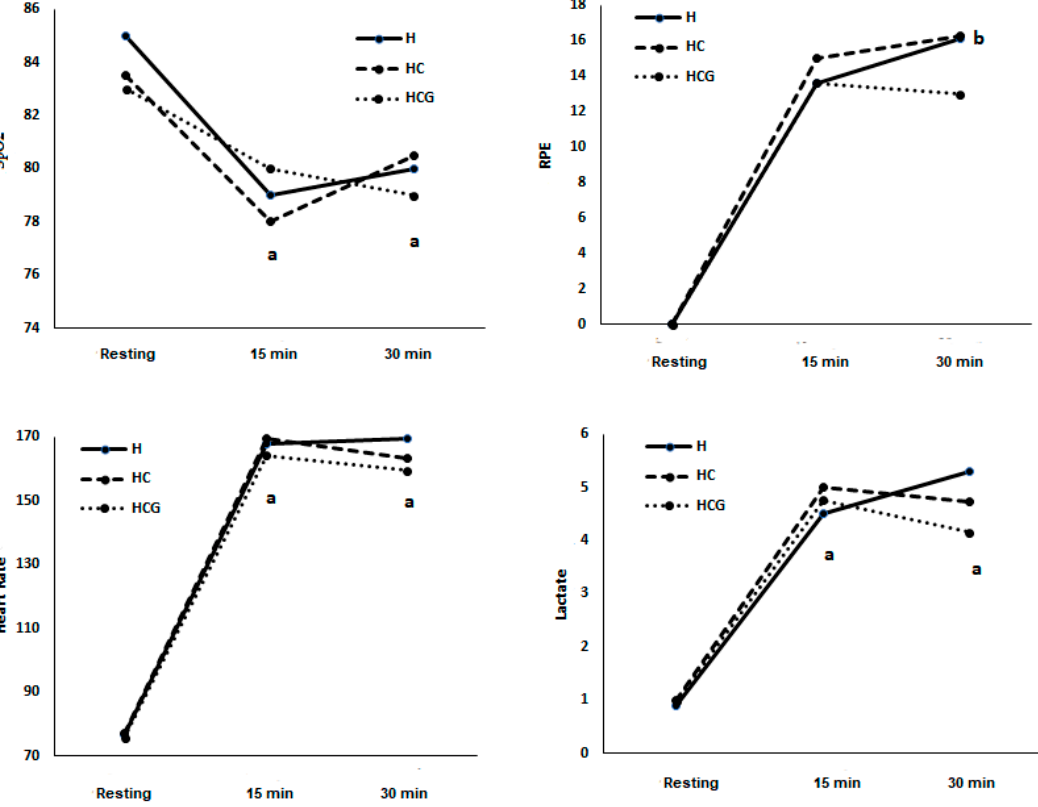
Figure 2. SpO 2 (%), rating of perceived exertion (RPE) (scale 6–20), heart rate (beats × min − 1 ), and lactate (mmol) demonstrated as a mean. Two-way ANOVA and Tukey’s test were used, n = 9 volunteers. a was different from the resting condition. b was different from the time 15’. For p < 0.05. Hypoxia (H), hypoxia + carbohydrate (HC), and hypoxia + carbohydrate + glutamine (HCG).